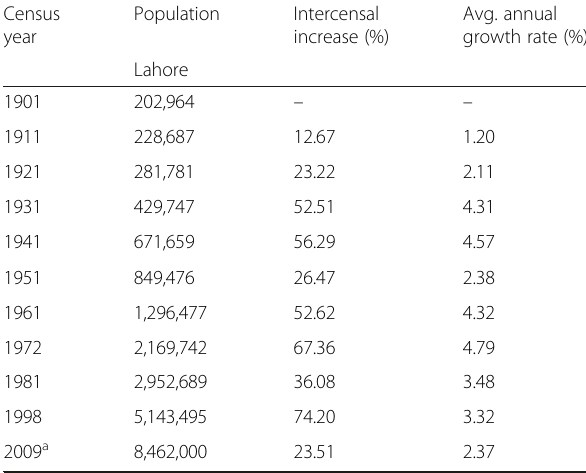
Table 1 Population, intercensal increase, and growth rates